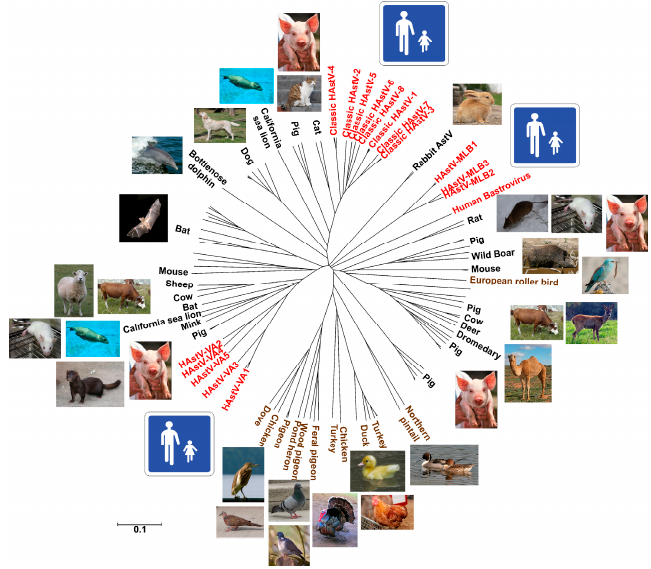
Figure 1. Phylogenetic tree of representative members of the Astroviridae family. The tree was constructed based on complete capsid amino acid sequences, using the Neighbor Joining method implemented in the MEGA6 program [27]. The tree is drawn to scale, with branch lengths in the same units as those of the evolutionary distances (p ‐ distance) used to infer the phylogenetic tree. All positions containing alignment gaps and missing data were removed only in pairwise sequence comparisons (pairwise deletion option). Viruses infecting birds are shown in brown, while viruses infecting humans are shown in red.